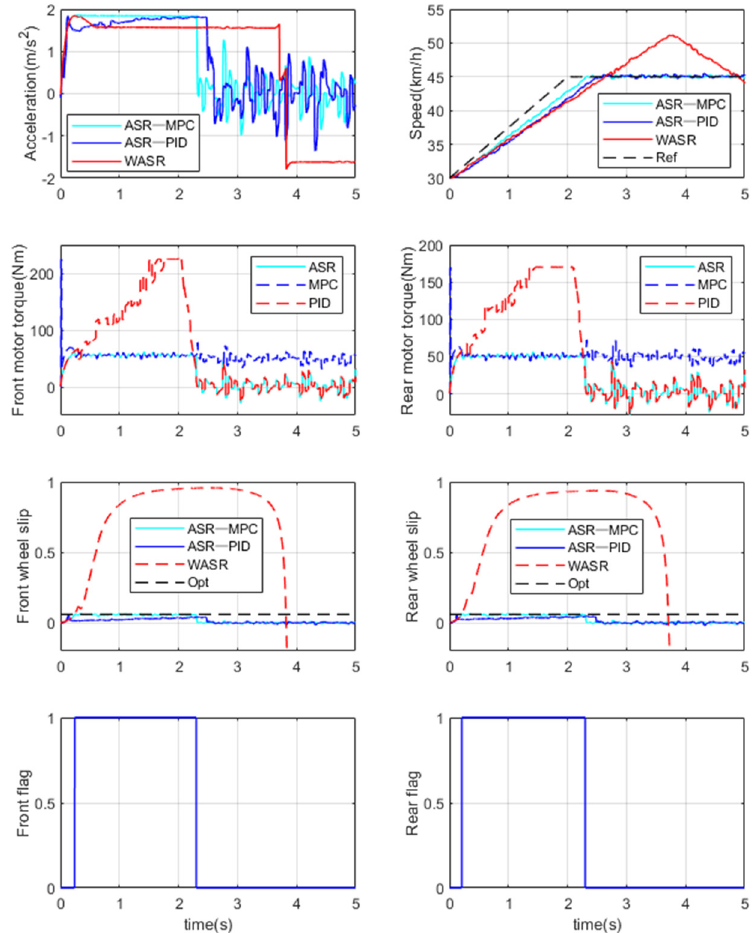
Figure 7. Vehicle accelerates under a low adhesion coefficient road.